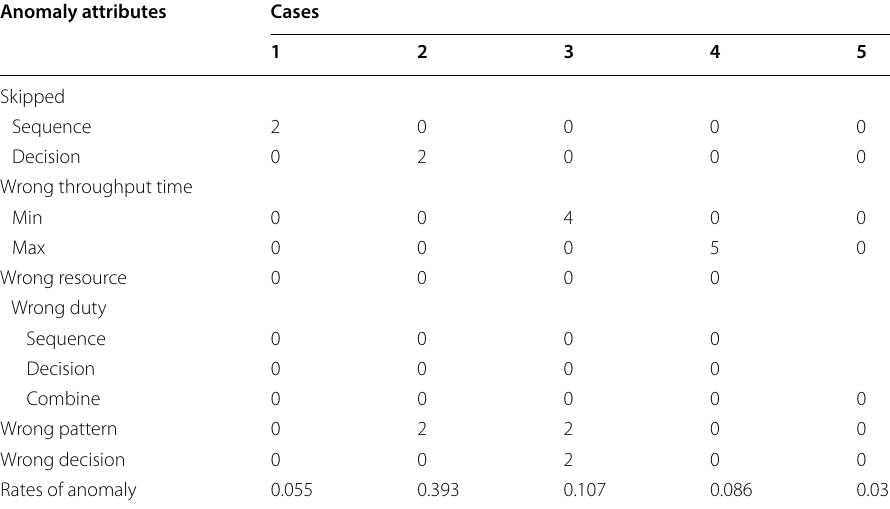
Table 8 Example of results of anomaly rate calculation